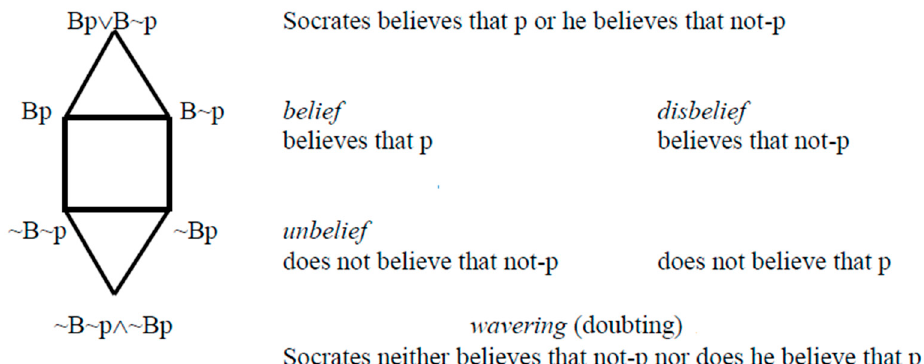
Figure 11. Σ 1 with the operator B.